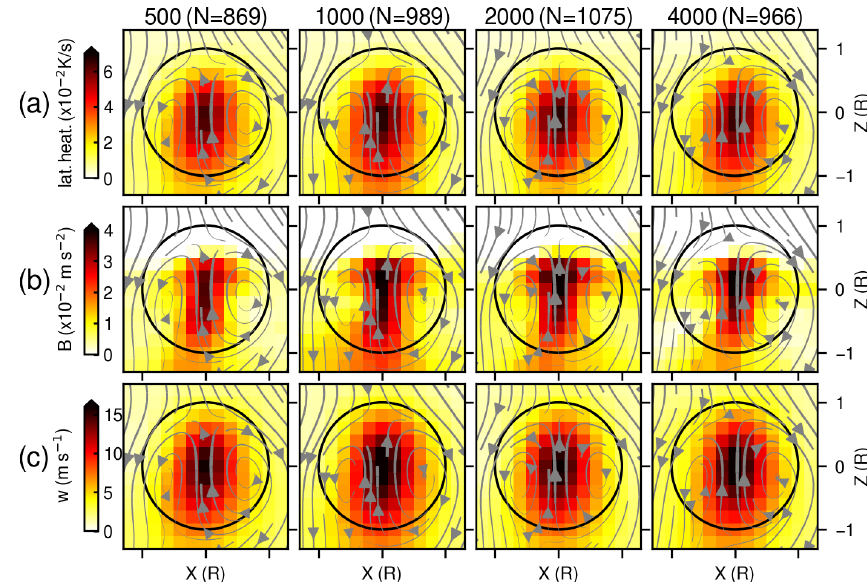
Figure 3. Composites for all tracked thermals, as in Fig. 2, but for (a) latent heating rates, (b) buoyancy, and (c) vertical velocity.